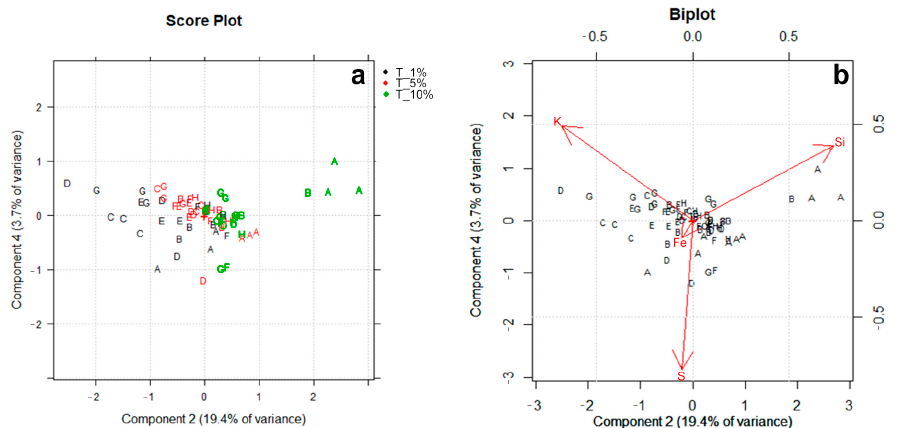
Figure 10. Results of the principal component analysis (PCA) performed on the XRF spectral dataset: PC2 versus PC4 scatter score plot ( a ) and the related biplot ( b ). Letters in ( a , b ) indicate the mock-ups under investigation; colors in ( a ) highlight different talc concentrations in the ground as reported in the legend (i.e., T_1%, T_5%, and T_10%, where the letter T stands for talc).